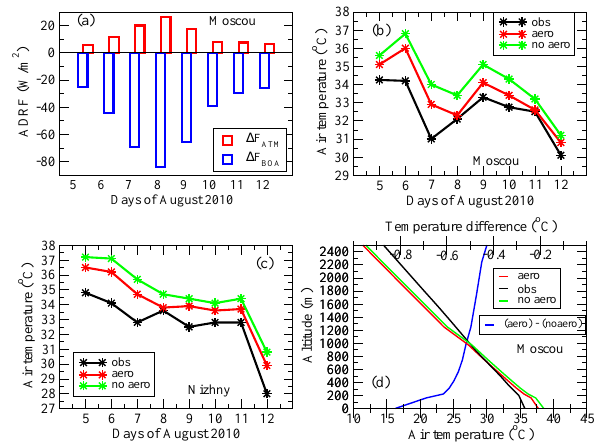
38 Fig. 9. (a) Diurnal-averaged shortwave aerosol direct radiative forc- ing (in Wm − 2 ) over Moscow simulated at the surface ( 1F BOA ) and within the atmosphere ( 1F ATM ). Diurnal-averaged near- surface air temperature (in ◦ C) simulated with and without aerosols and observed at the meteorological station of (b) Moscow Domode- dov and (c) Nizhny Novgorod. (d) Vertical profiles of the diurnal- averaged air temperature (in degrees) for 8 August at midday, simu- lated with and without aerosols and observed at the Moscow meteo- rological station. Temperature differences between both simulations are indicated.